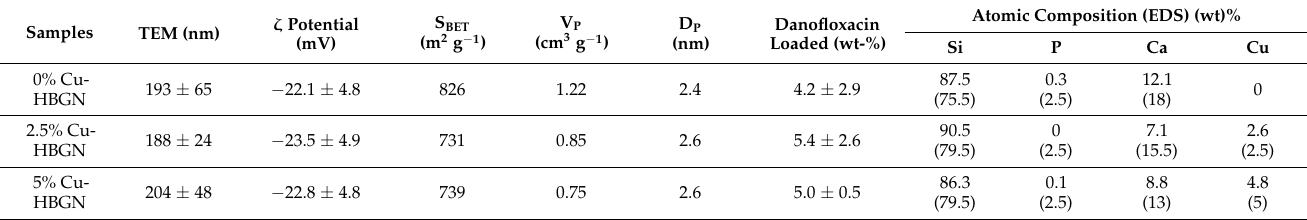
Table 2. Physicochemical properties of HBGN obtained by TEM, DLS, ζ potential, N 2 adsorption, TG/DTA and EDS. The error of the mean values represents a coefficient of variation of <7% for each experimental value in the